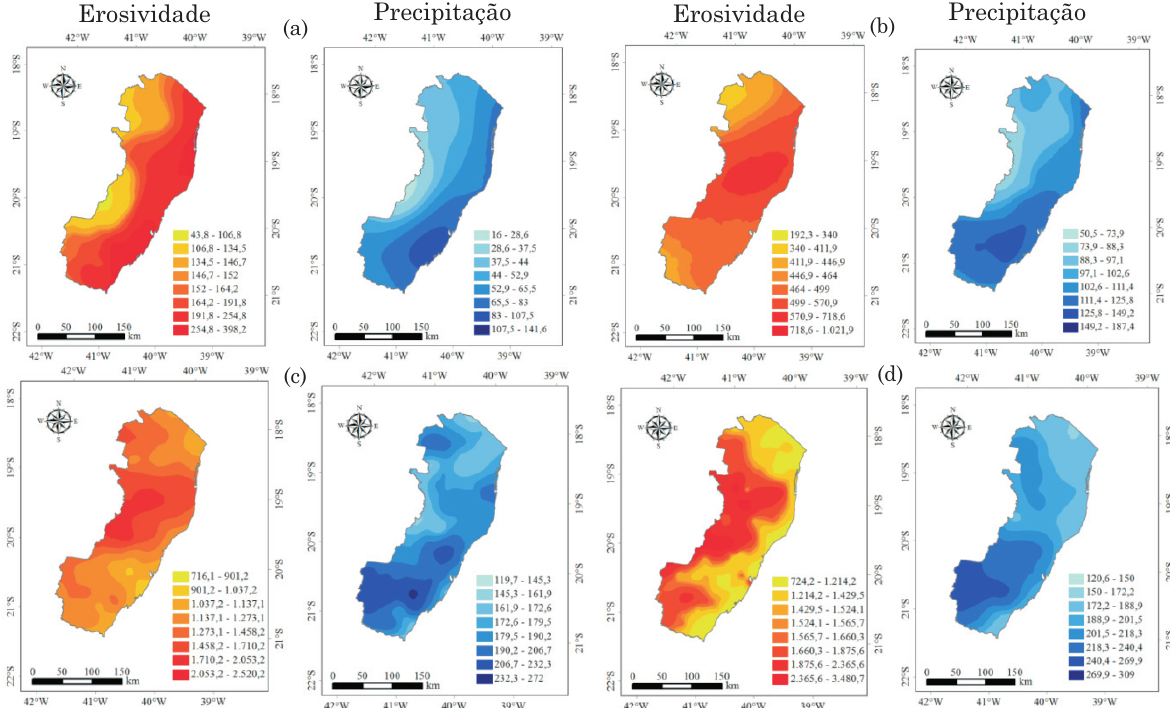
Figura 10. Mapas de erosividade (MJ ha -1 mm h -1 ano -1 ) e precipitação (mm), ambos mensais, para o Estado do Espírito Santo (a) setembro; (b) outubro; (c) novembro; (d)